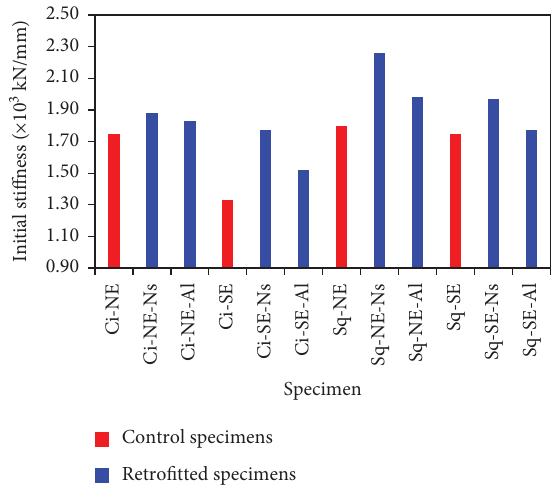
Figure 14: Comparing the stifness of columns in diferent states.